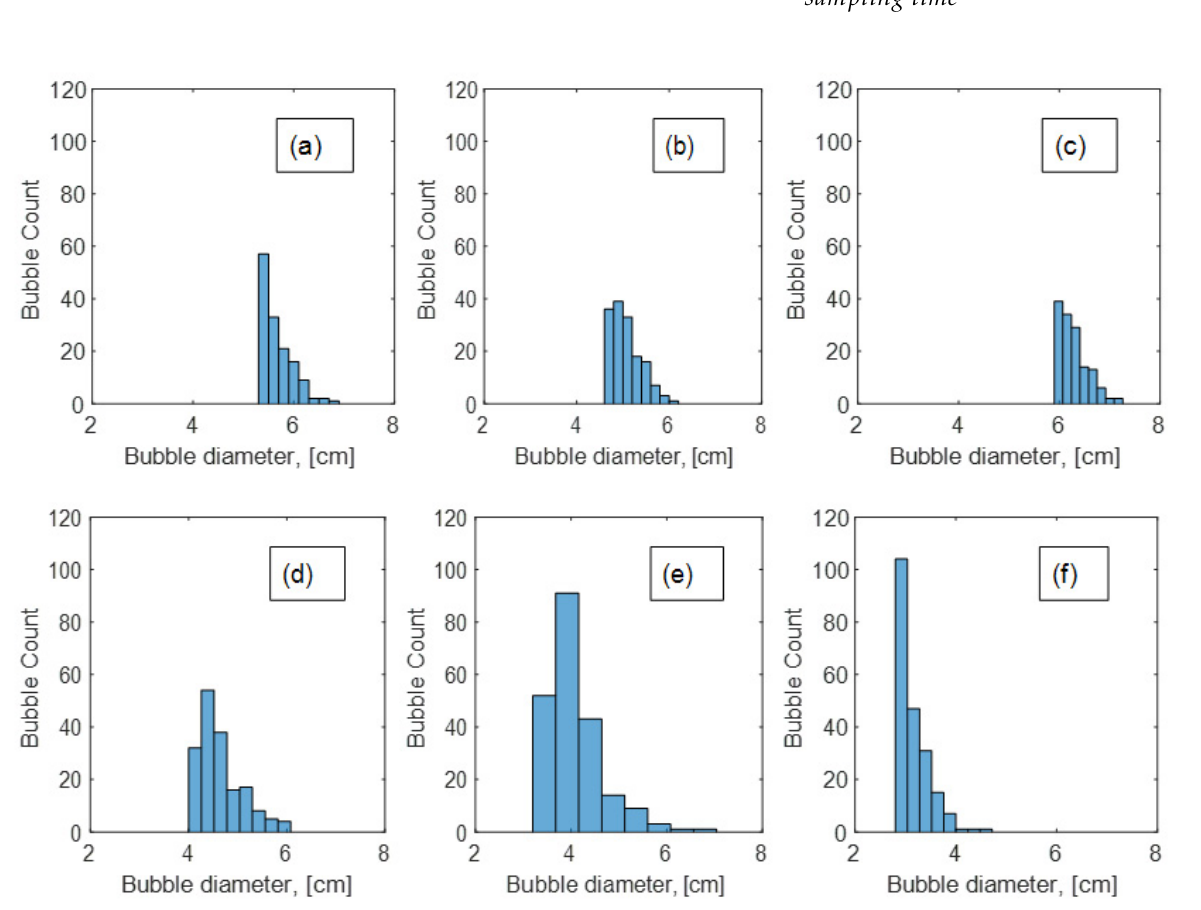
Figure 10. Bubble count vs. bubble diameter at superficial gas velocities of 0.4 m/s, 0.35 m/s, 0.3 m/s, 0.25 m/s, 0.176 m/s, and 0.15 m/s illustrated in the pictures from ( a – f ), respectively. The plot of bubble frequency at different superficial gas velocities from the CPFD model, ECT measurement, and Agu et al. [41] correlation are compared in Figure 11. The result from the CPFD model shows that bubble frequency increases with an increase in superficial gas velocity up to 0.25 m/s and decreases further. The increase in bubble fre- quency up to 0.25 m/s is due to the formation of a large number of smaller size bubbles in the bed (as shown in Figure 10d–f). Due to the coalescence of the smaller bubbles to form larger diameter bubbles, the bubble frequency decreases for the higher gas velocities. At superficial gas velocity of 0.35 m/s, there is a slight increment in the bubble frequency due to split of the large diameter bubbles. The CPFD model predicts the bubble frequency close to the experimental data at higher gas velocities and overpredicts the bubble fre- quency at lower gas velocities. However, the simulations follow a similar trend of the